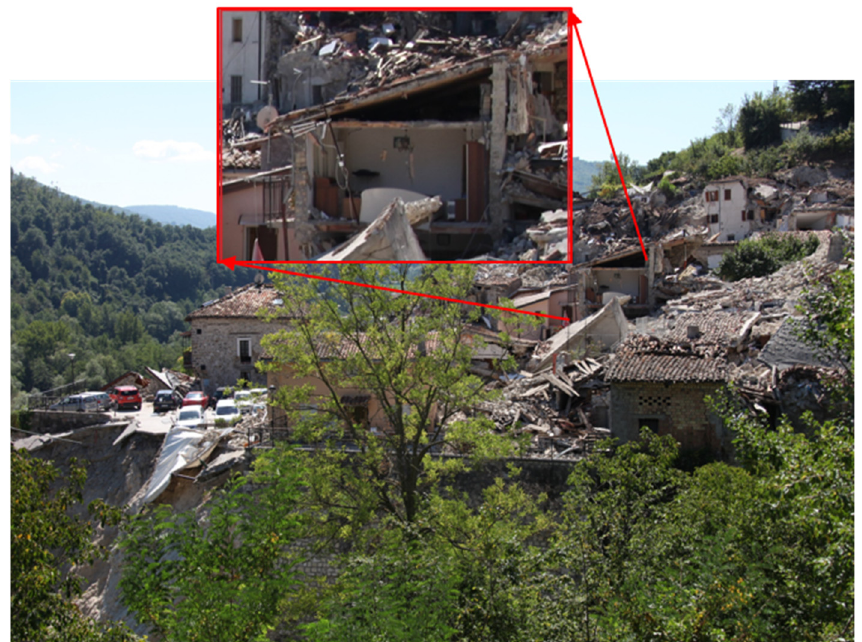
Figure 3. Exploration of a snapshot by AR. The augmented information highlights in red the state of the damage within the buildings at Pescara del Tronto after the earthquakes in central Italy in August 2016 (photo credits: Raffaele Azzaro).